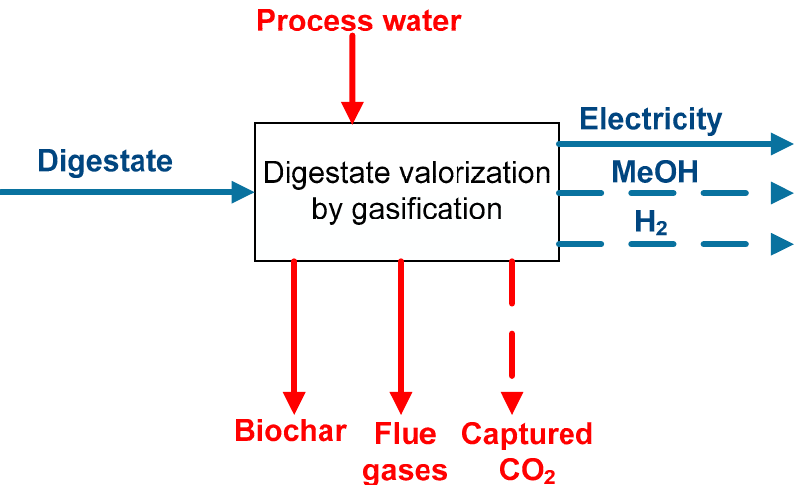
Figure 5. Simplified scheme for the environmental input data analysis (blue lines: CO 2eq savings; red lines: CO 2eq emissions).